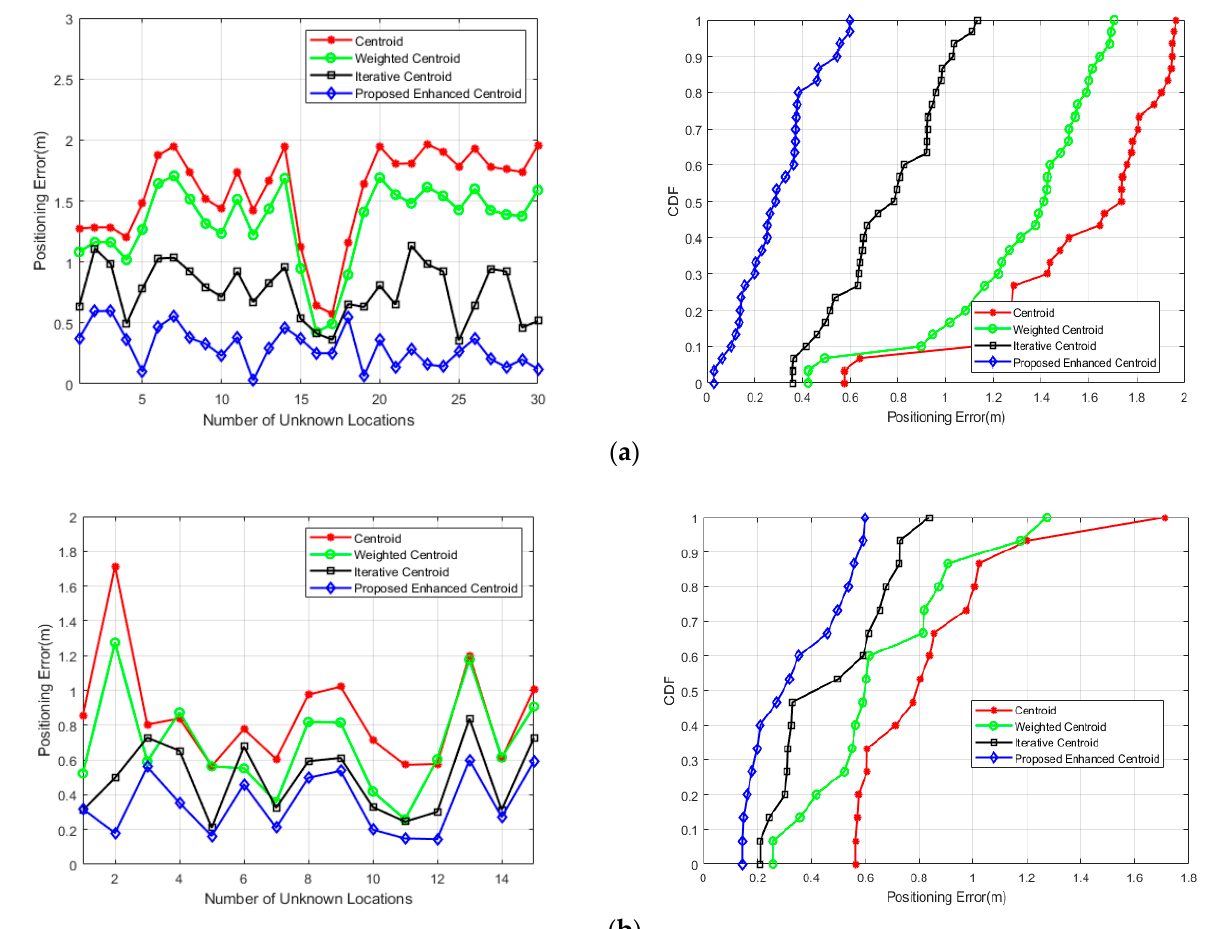
Figure 9. Positioning errors and cumulative distribution function (CDF) of the positioning error of the proposed enhanced centroid algorithm and the other positioning algorithms: ( a ) The office room; ( b ) The corridor.